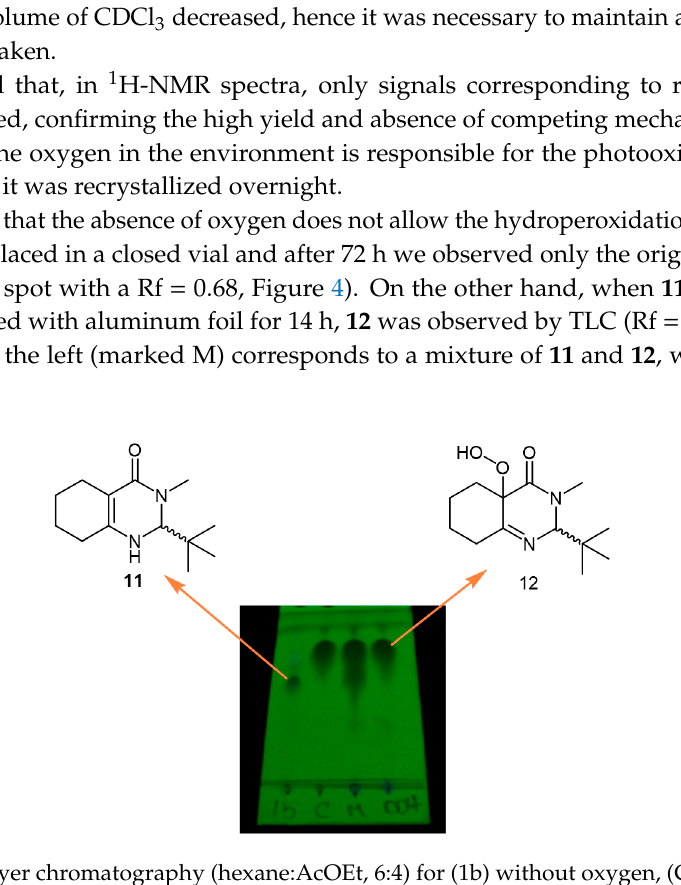
Figure 3 . Kinetic study by 1 H-NMR of environmental exposure of 11 .